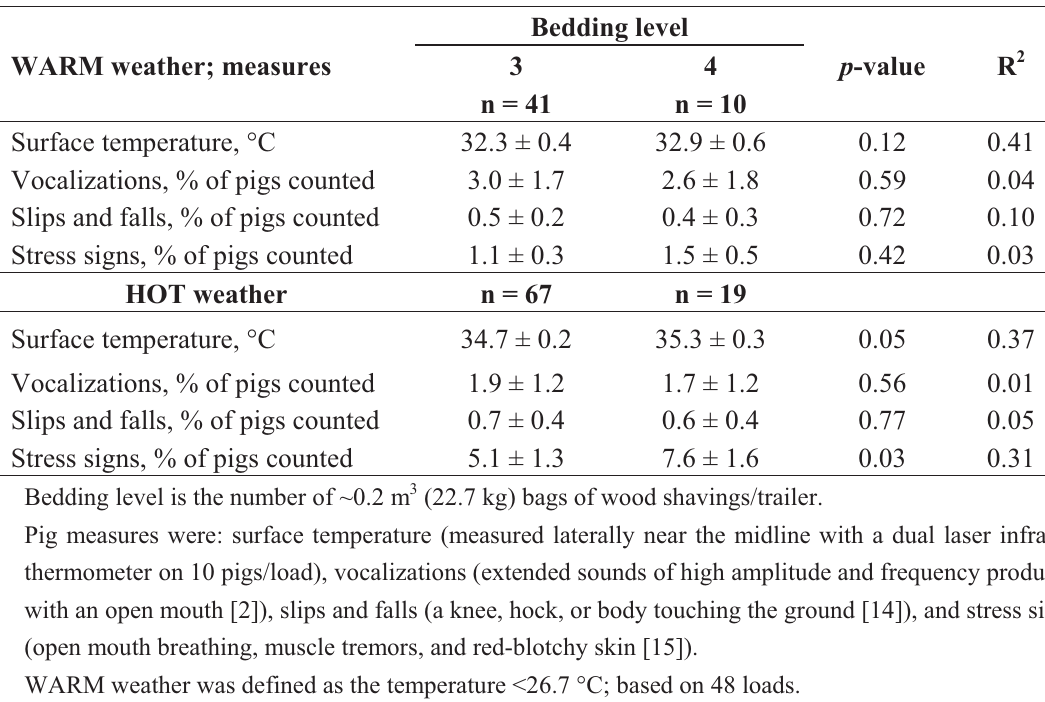
Table 4. Experiment 1. Effects of bedding level 1 on pig measures 2 in market weight pigs in WARM 3 and HOT 4